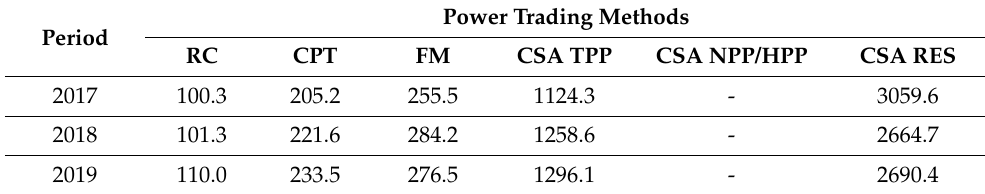
Table 2. Weighted average prices of capacity using different trading methods: the second price zone, thousand rubles/MW.